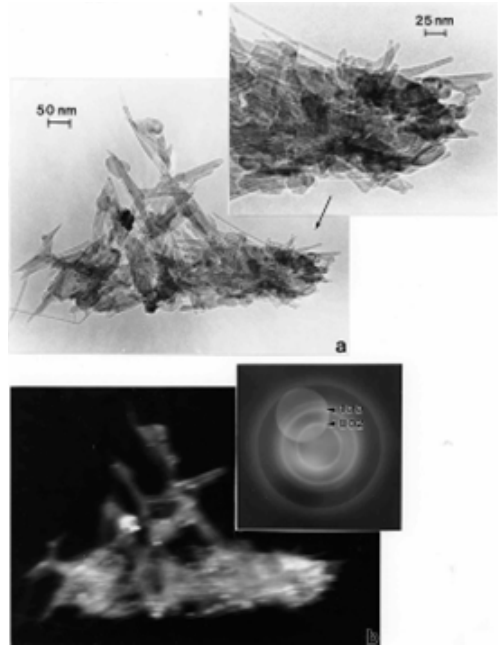
Figure 3: Carbon nanotube and related carbon (fullerene) nanoparticle aggregate in the El Paso, TX, USA outdoor air. (a) Bright-field TEM image. (b) Dark-field TEM image using the diffracted regime within the objective-aperture double exposure in the SAED pattern insert. Prominent hexagonal graphite (a = 0.25 nm, c = 0.67 nm) diffraction rings are indicated in the SAED pattern insert.